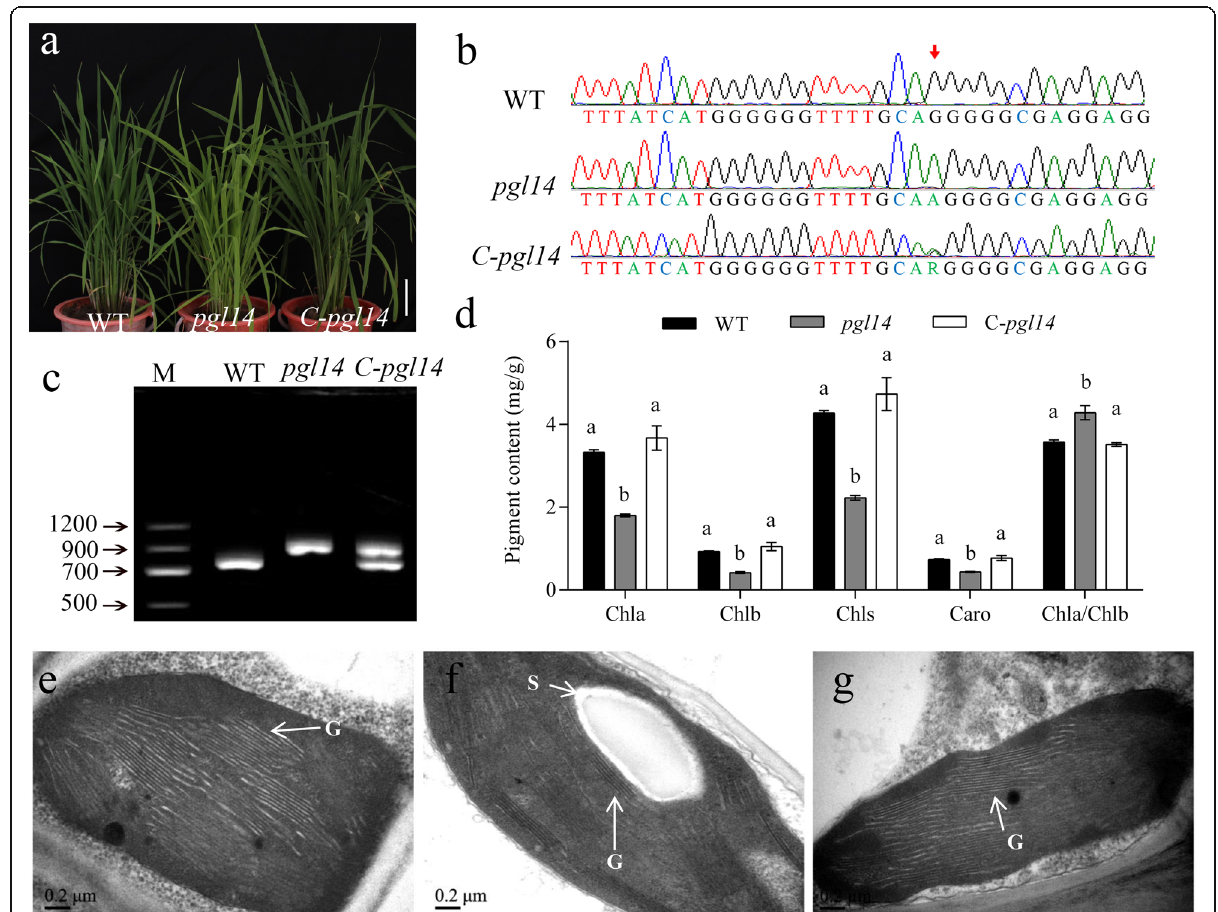
Fig. 3 Functional complementation of OscpSRP54a . a Phenotype of WT, pgl14 and complementary line C- pgl14 . Bar = 20 cm; b Sequence analysis of the mutation site (red arrow) in WT, pgl14 and C- pgl 14; c OscpSRP54a transcripts in WT, pgl14 and C- pgl14 ; d Pigment contents in WT, pgl14 and C- pgl14 in 8-week-old leaves. Data are means ± SD ( n = 3). Means with different letters indicate significant differences according to One-way ANOVA and Duncan ’ s test ( p ≤ 0.01). Chloroplast ultrastructure of WT ( e ), pgl14 ( f ) and C- pgl14 ( g ) at the tillering stage. G, grana thylakoid; S, starch